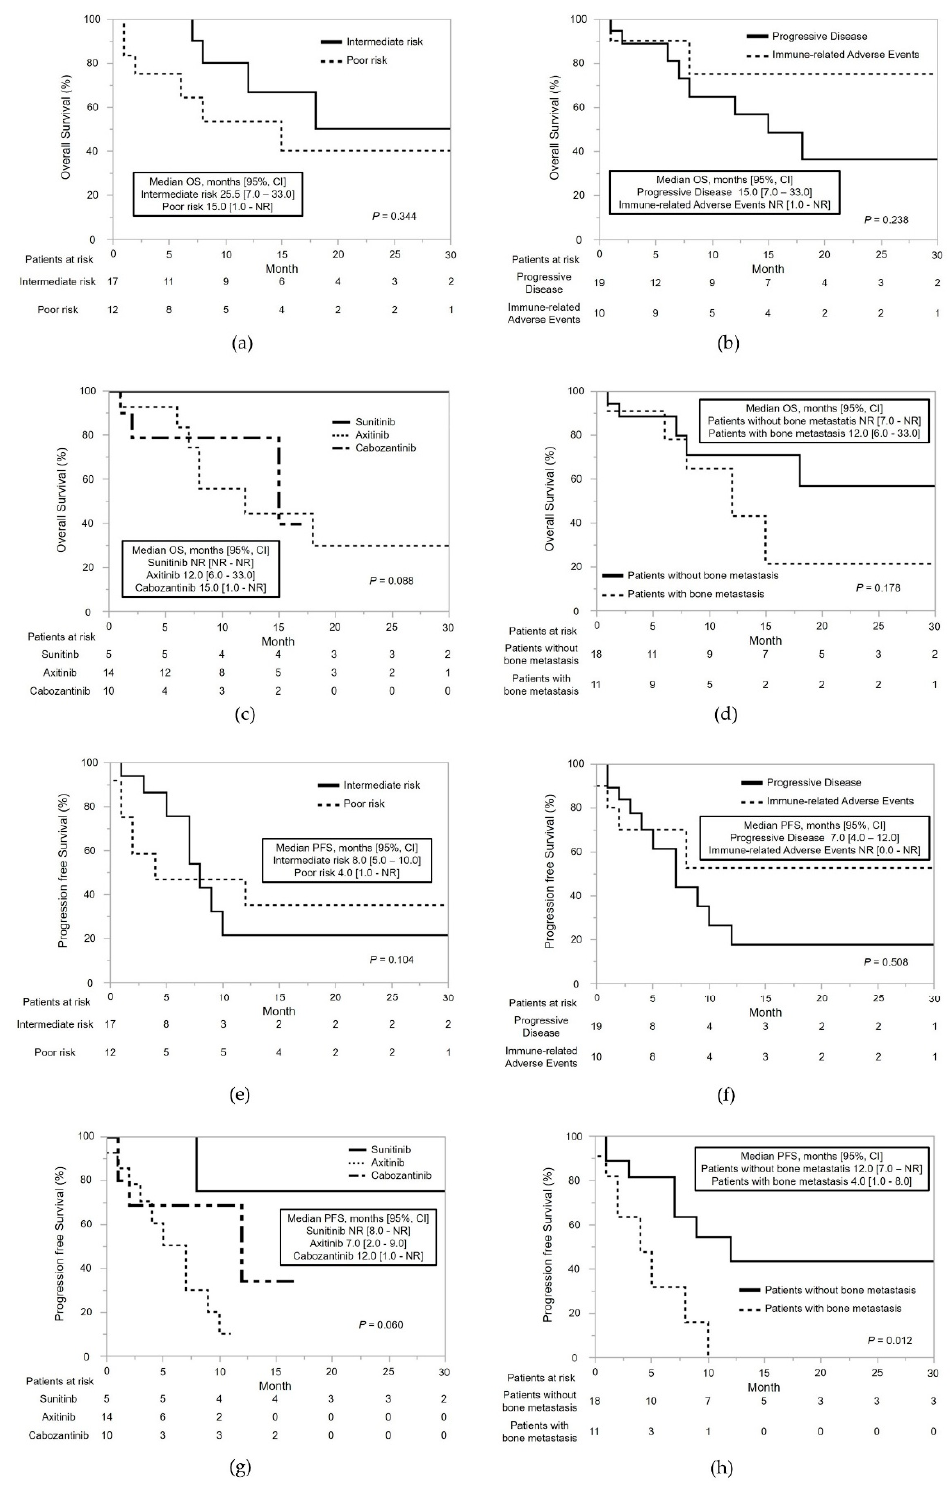
Figure 3. Overall survival (OS) and progression-free survival (PFS) of patients treated with molecular- targeted therapies (MTTs) after nivolumab plus ipilimumab combination therapy (NIVO+IPI). ( a ) OS from the date of the first MTT in patients who discontinued NIVO+IPI for intermediate/poor risk metastatic renal cell carcinoma (mRCC), as determined according to the International Metastatic Renal Cell Carcinoma Database Consortium risk classification. ( b ) OS from the date of the first MTT after NIVO+IPI in patients stratified according to the reason for the NIVO+IPI